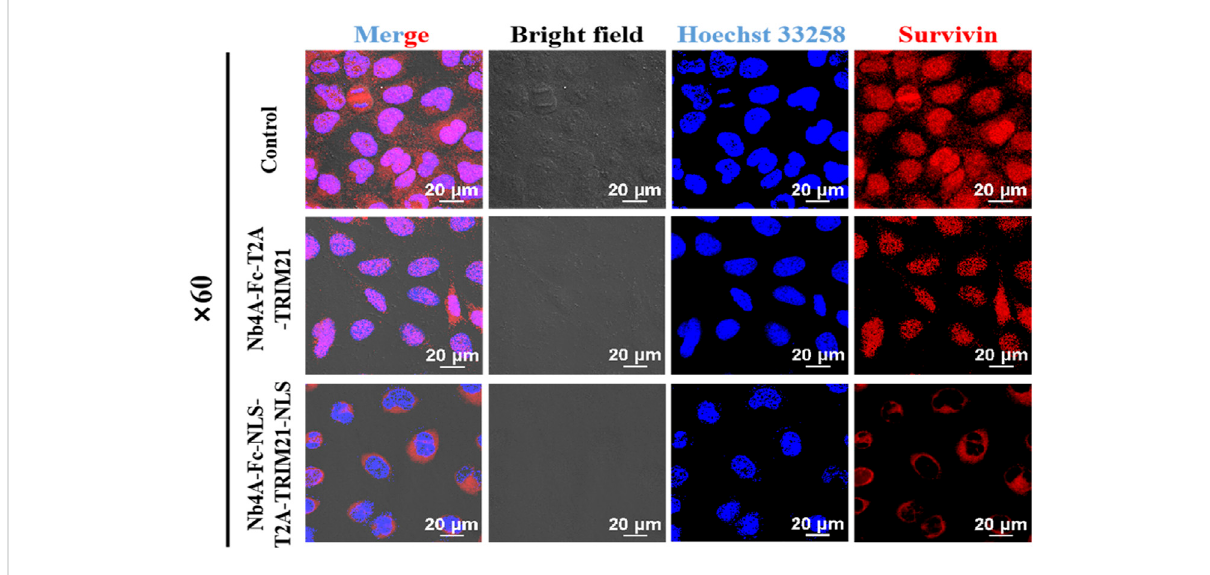
FIGURE 4 Targeteddegradationofsurvivinanalyzedbyimmuno fl uorescence.MCF-7cellsweretransfectedwiththerecombinantplasmidspcDNA3.1(+)-